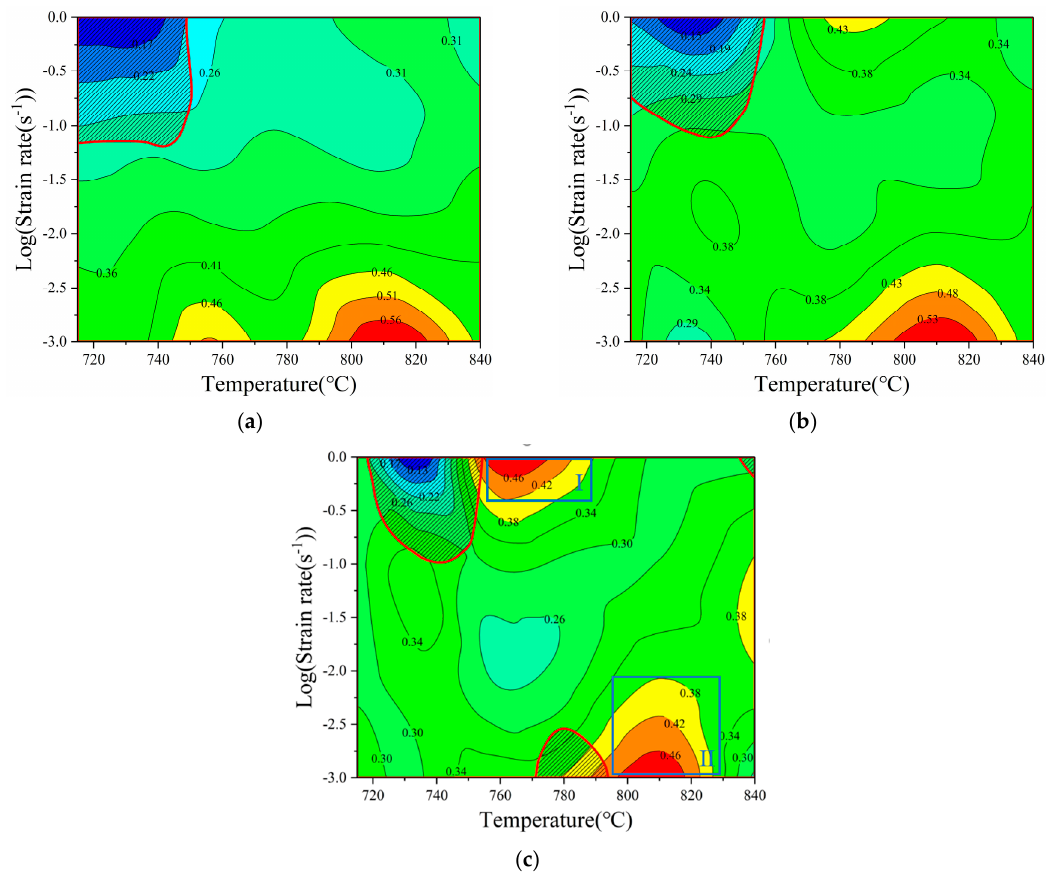
Figure 9. Processing maps of Ti-6554 alloy at the true strain of: ( a ) 0.3; ( b ) 0.6; ( c ) 0.9.